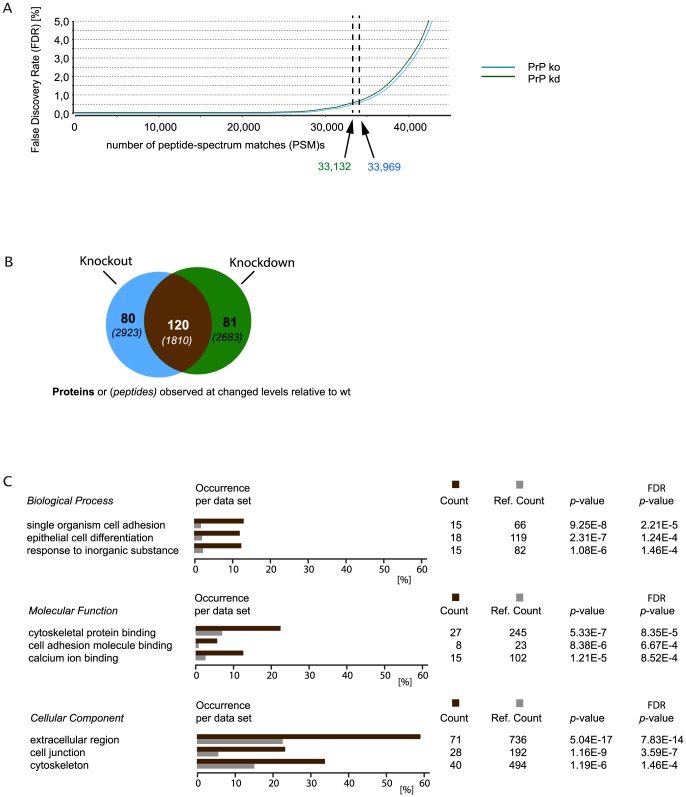
PrP deficiency generated by CRISPR/Cas9-mediated gene knockout or stable shRNA-mediated knockdown manifests in highly reproducible changes to the expression of more than hundred proteins in NMuMG cell model.(A) Chart depicting number of peptide-spectrum matches versus false discovery rate (FDR). 33,132 and 33,969 peptide-to-spectrum matches (PSMs) passed the set FDR threshold of 0.5 in PrP knockout and knockdown datasets, respectively. (B) Venn diagram depicting overlap in proteins (peptides) whose expression was altered in clones made deficient for PrP expression by the two aforementioned methods. (C) Several gene ontology (GO) classifiers were significantly overrepresented when their occurrence was compared amongst the 120 proteins whose abundance levels were consistently altered by PrP knockout (or knockdown). The list of all 3254 mouse NMuMG protein groups detected in this study served as the reference data set for these analyses. Colour code: dark brown, proteins whose abundance levels were changed in both PrP kd and ko data sets; grey, subset of proteins within reference data set assigned to a given ‘GO’ classifier.